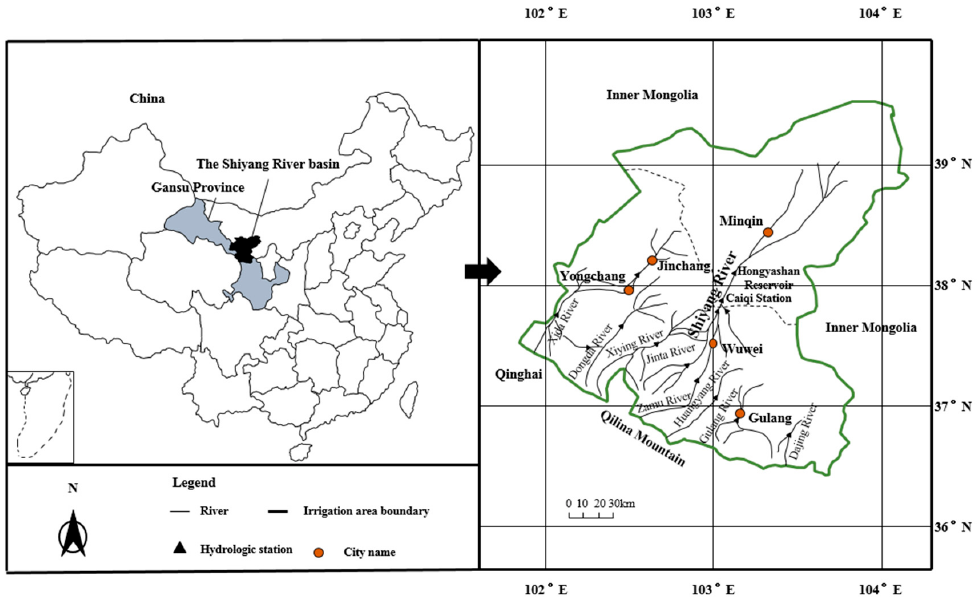
Figure 1. Sketch map of the Shiyang River basin in northwest China.